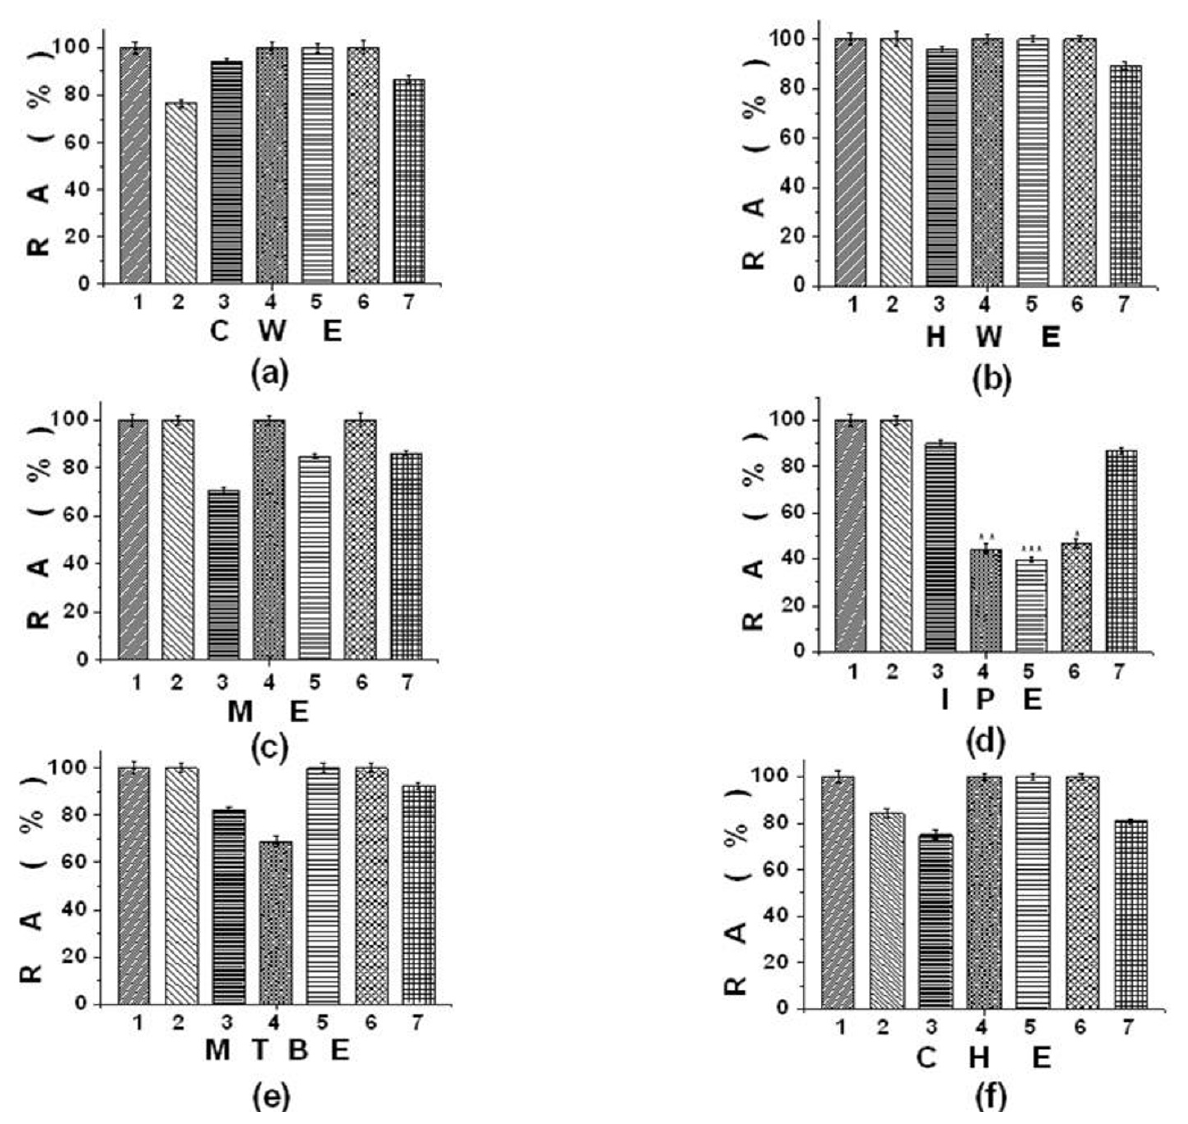
Figure 1 The percent relative enzyme activity (RA %) of porcine pancreatic a - amylase (PPA) on inhibition with different extracts . (a) Cold water extracts-CWE (b) Hot water extracts-HWE (c) Methanol extracts-ME (d) Isopropanol extracts-IPE (e) Methyl-tertiary-butyl-ether extacts- MTBE (f) Cyclohexane extracts-CHE of the listed plants. Pure porcine pancreatic a -amylase serves as control. The data is indicated as the mean ± SEM; (n = 3). The students F-test was used and the bars with different asterisks (***, **, *) show significant difference with respect to control (P < 0.05). 1 Control 2 A. vera 3 C. fistula 4 L. usitatisumum 5 M. alba 6 O. tenuiflorum 7 T. foenum